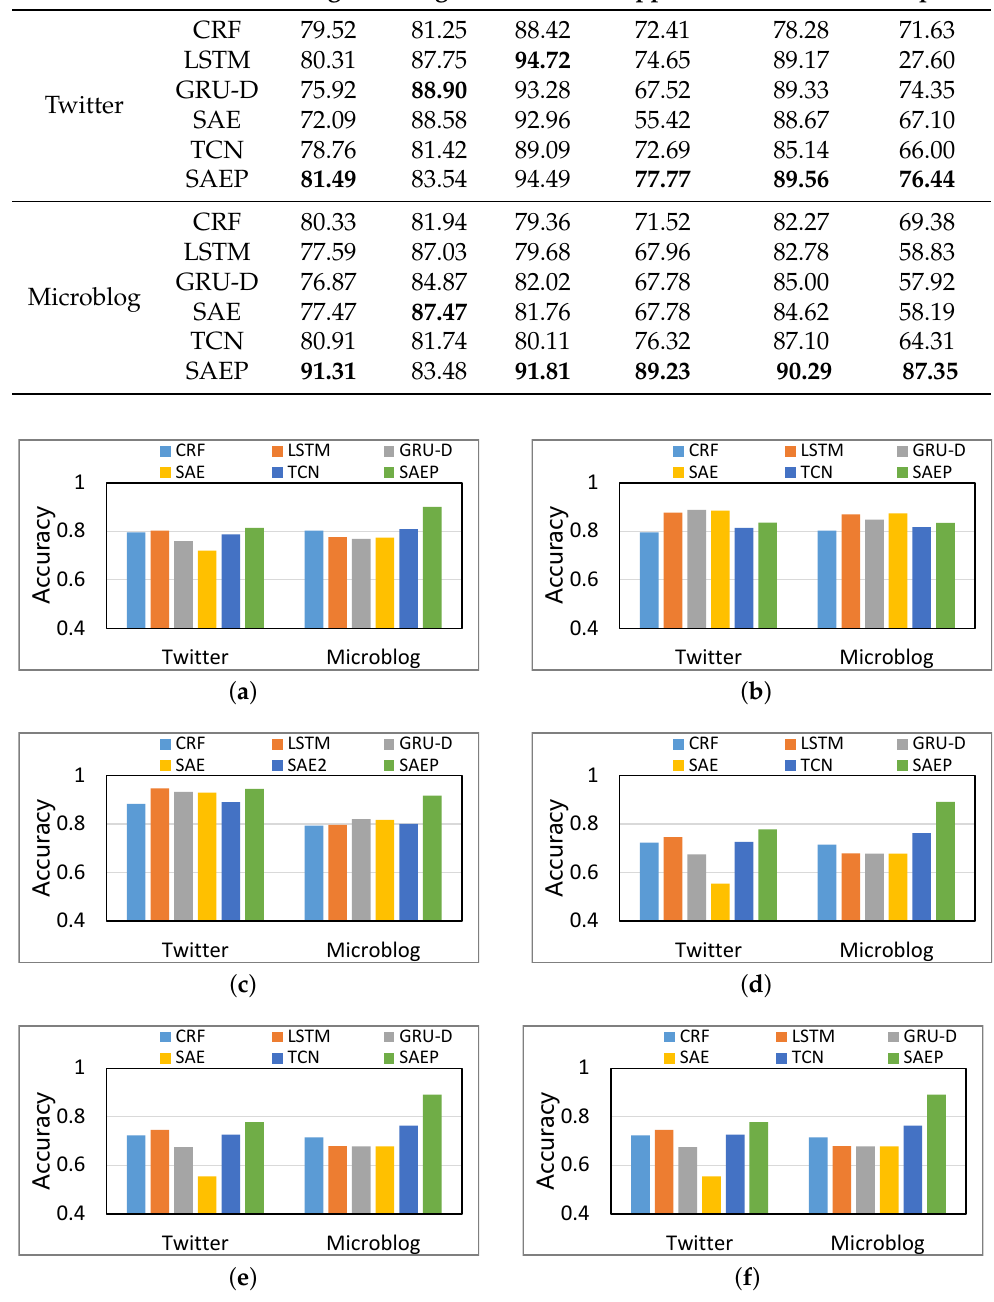
Figure 8. Comparison of the accuracy of different emotion categories with different methods ( a ) Anger ( b ) Disgust ( c ) Fear ( d ) Happiness ( e ) Sadness ( f )